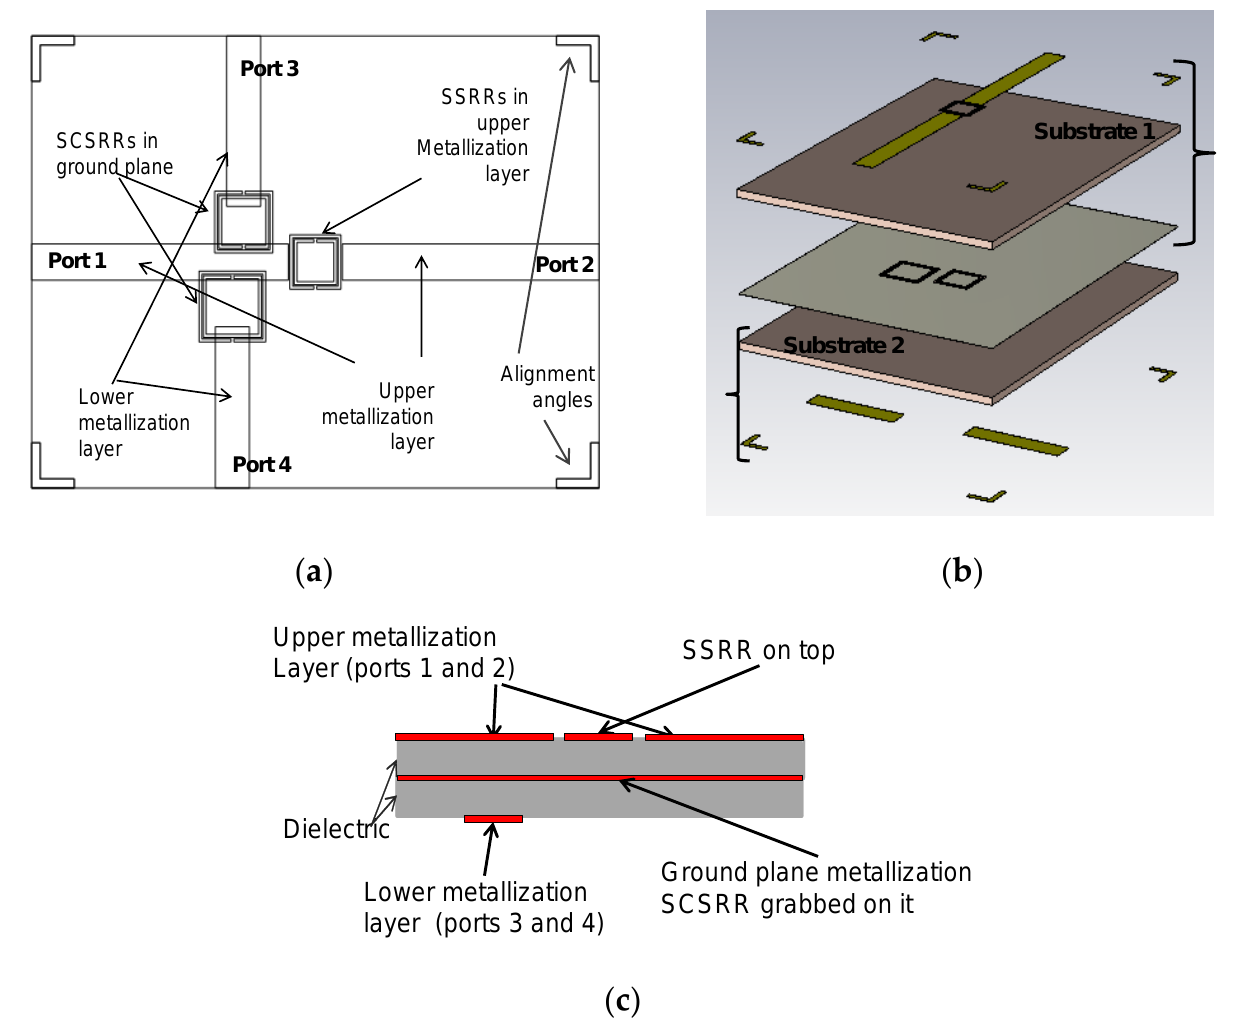
Figure 22. ( a ) Top view overlapped layer distribution of 2-layer triplexer, which is SSRR and SCSRR based. ( b ) Perspective view of layers composition of 2-layer triplexer, which is SSRR and SCSRR based. ( c ) Front view layer distribution.